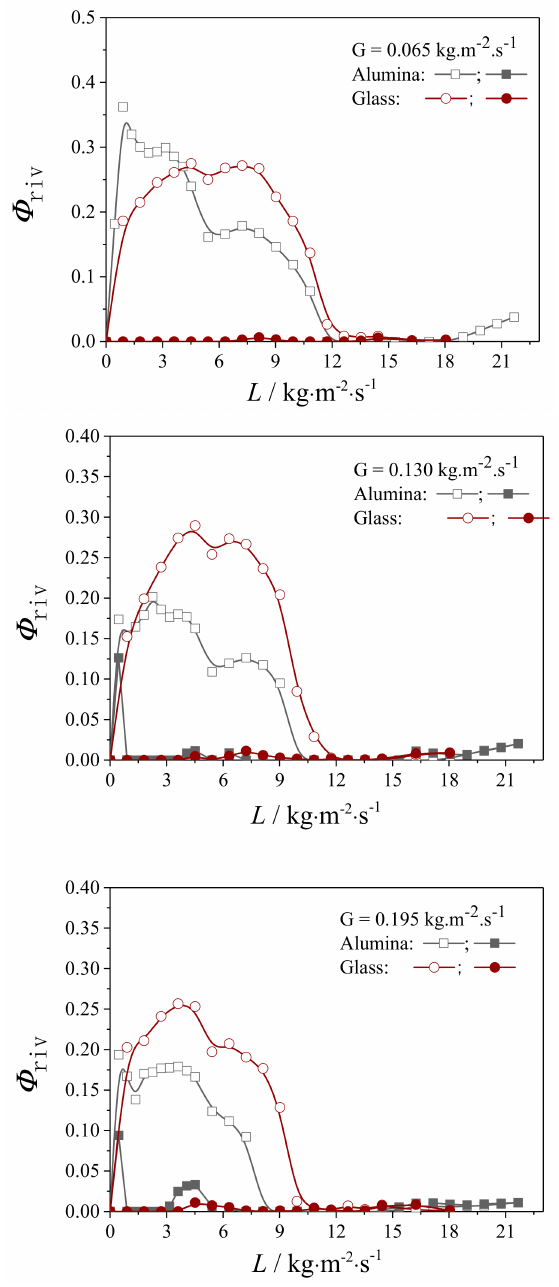
Figure 6. Fraction of rivulet flow over the packing